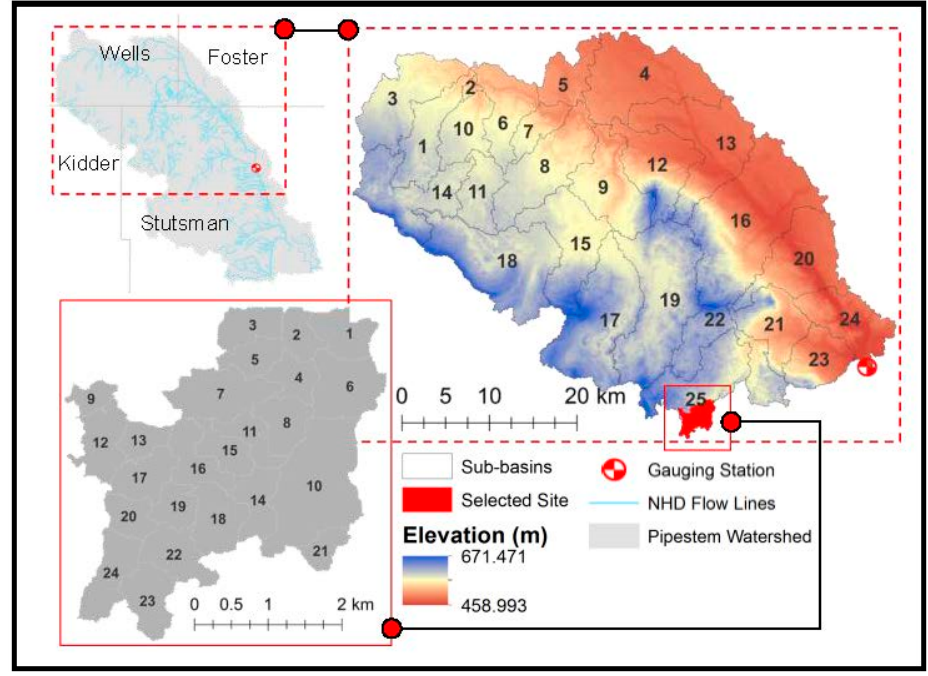
Figure 2. Location of the study area in the Pipestem watershed in North Dakota and the delineated sub ‐